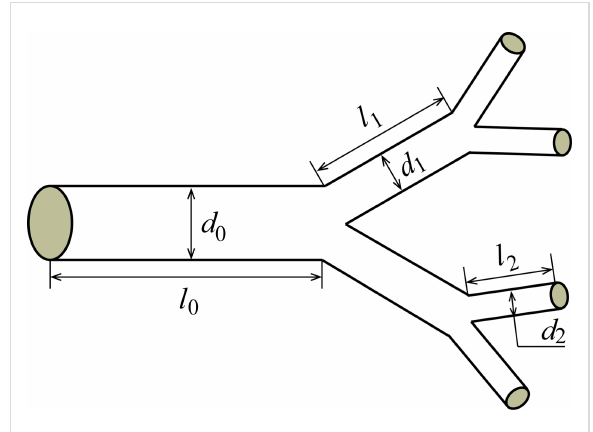
Figure 2: Schematic of a self-similar fractal tree-like microchannel network with branching number N = 2 and total number of branching levels m = 2. l k ( k = 0, 1, 2) is the length of the microchannel at the k th level and d k ( k = 0, 1, 2) is the hydraulic diameter of the microchannel at the k th